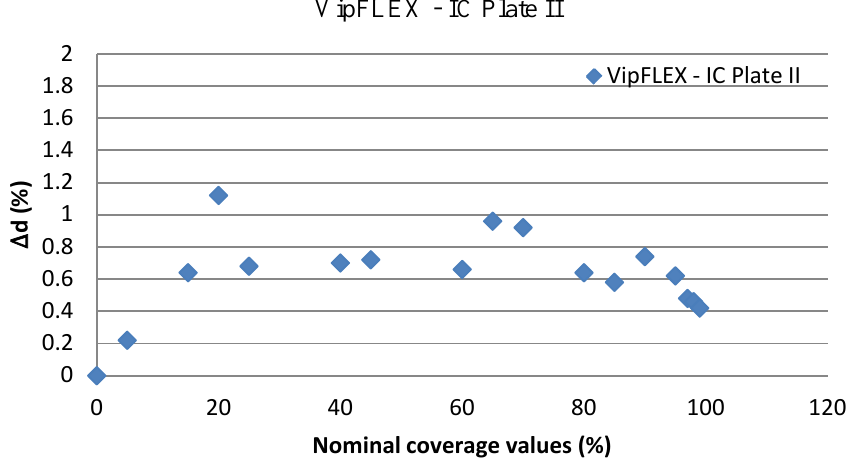
Figure 12. Comparison of coverage values calculated by VipFLEX and IC Plate